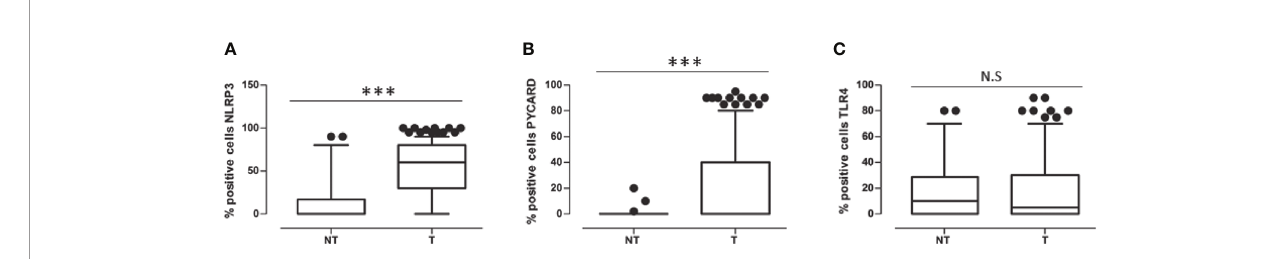
FIGURE 2 | (A) Expression levels of NOD-like receptor protein 3 (NLRP3) in Non Tumoral (NT) respect to Tumoral area; (B) Expression levels of Apoptosis- Associated Speck-Like Protein Containing a Pyrin and CARD domain (PYCARD) in Non Tumoral (NT) respect to Tumoral area; (C) Expression levels of Toll like receptor 4 (TLR4) in Non Tumoral (NT) respect to Tumoral area. Values are expressed as the median (horizontal bold line in each box), with the 5th and 95th percentiles and the furthest points that are not outliers (top and bottom of each ⊺ ⊥ bar). Dot indicates outliers. ***p < 0.001; NS, not signi fi cant. TABLE 2 | Relationship between tumor markers and clinicopathological features.